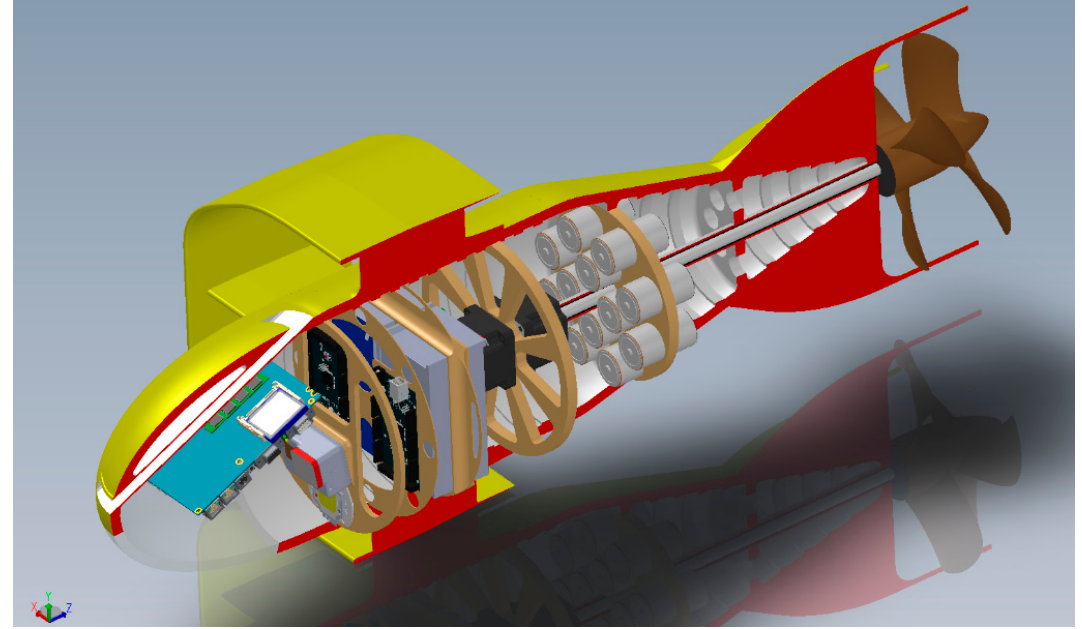
Figure1. Prospectivecross-sectionoftheautonomousunderwatervehicles(AUV)Albacore: Theinterior Figure 1. Prospective cross-section of the autonomous underwater vehicles (AUV) Albacore: The sections and supports are visible. interior sections and supports are visible. Table 1. AUV: General characteristics and performances